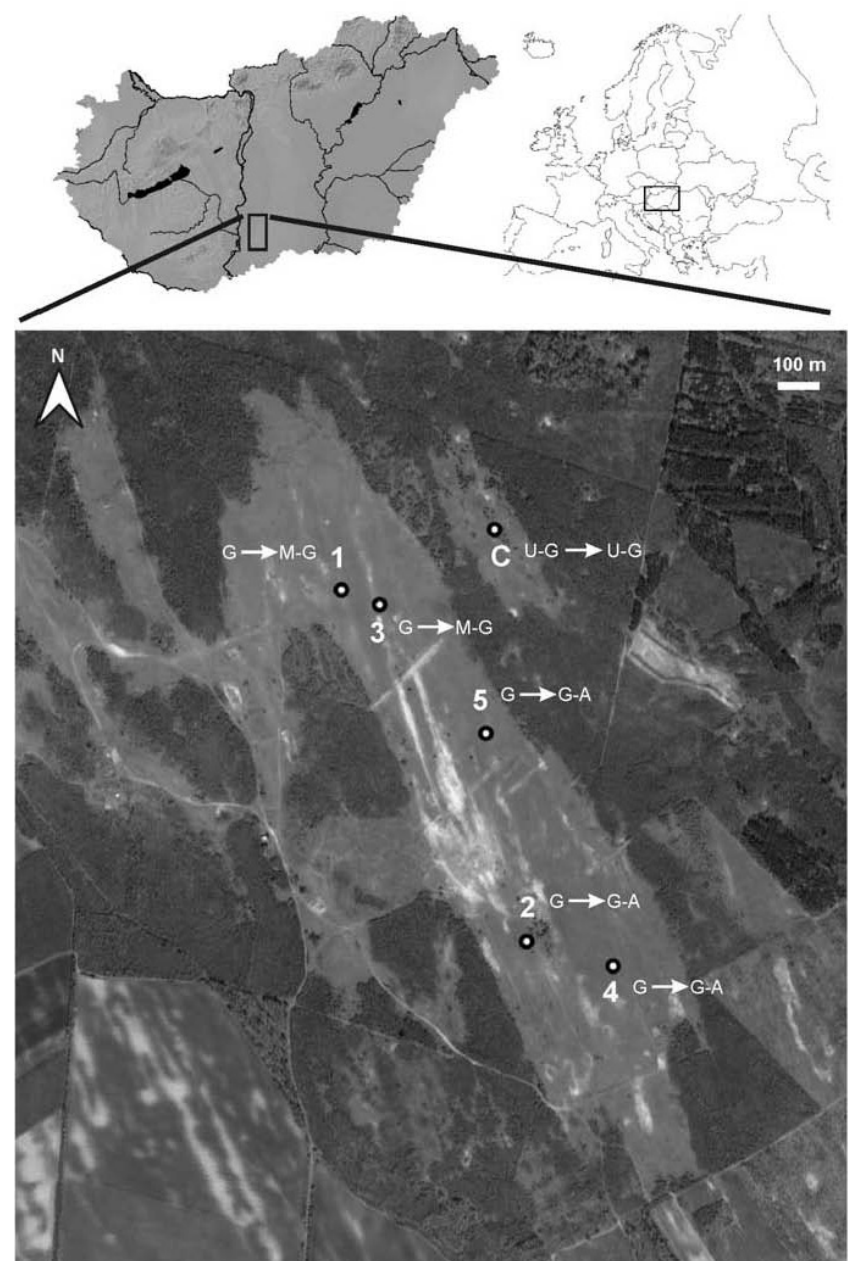
Fig. 1. Location and land use-changes of the studied sites ( G : grazed; G–A : grazing-abandoned; M–G : moderately grazed; U–G : un- grazed). Letters to the left of the arrow indicate land use in 2012 and 2013; letters to the right of the arrow indicate land use in 2014, 2015 and